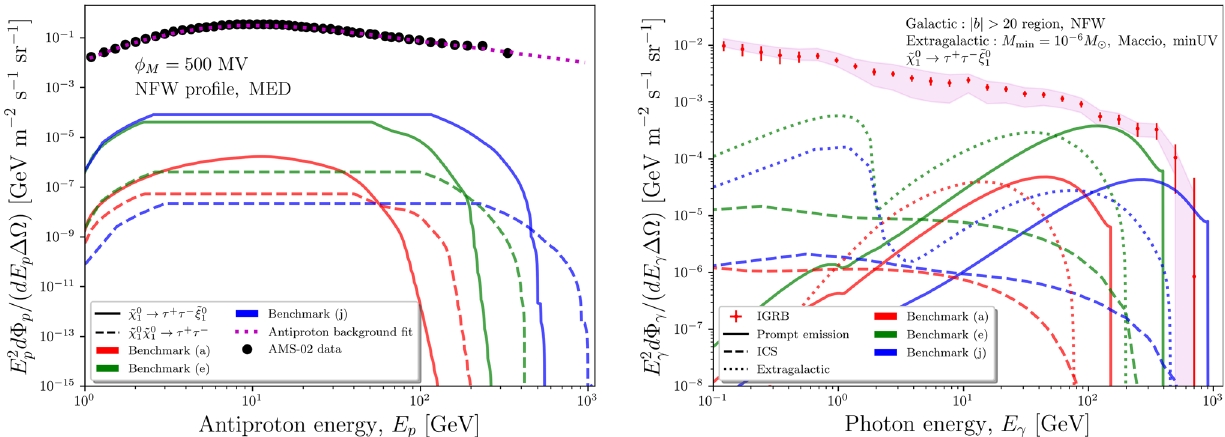
Fig. 2 The gamma ray flux from the decay (left panel) and annihilation (right panel) of ˜ χ 0 and ICS. Also shown are the Fermi-LAT data points